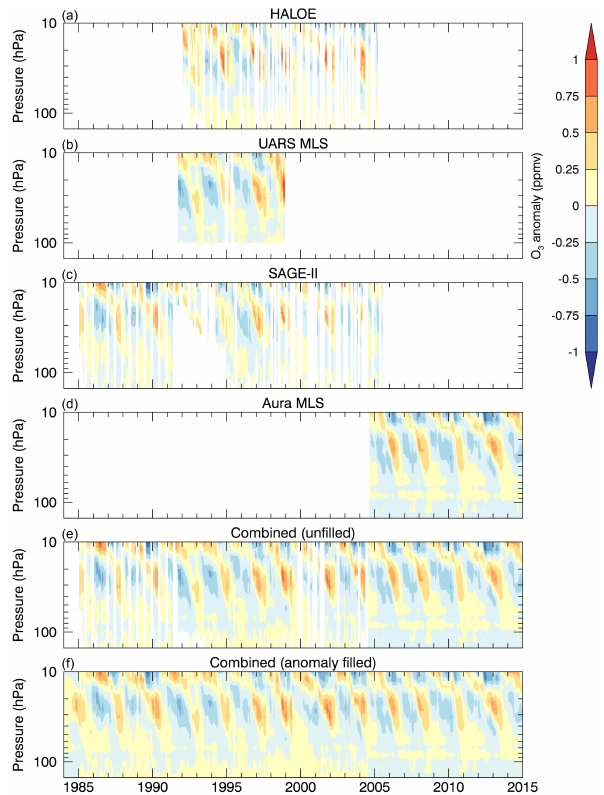
Figure 13. The tropical average (10 ◦ S–10 ◦ N) ozone concentration anomaly as a function of height and time for each satellite data set in SWOOSH (a – d) , as well as the two combined products (e – f) .